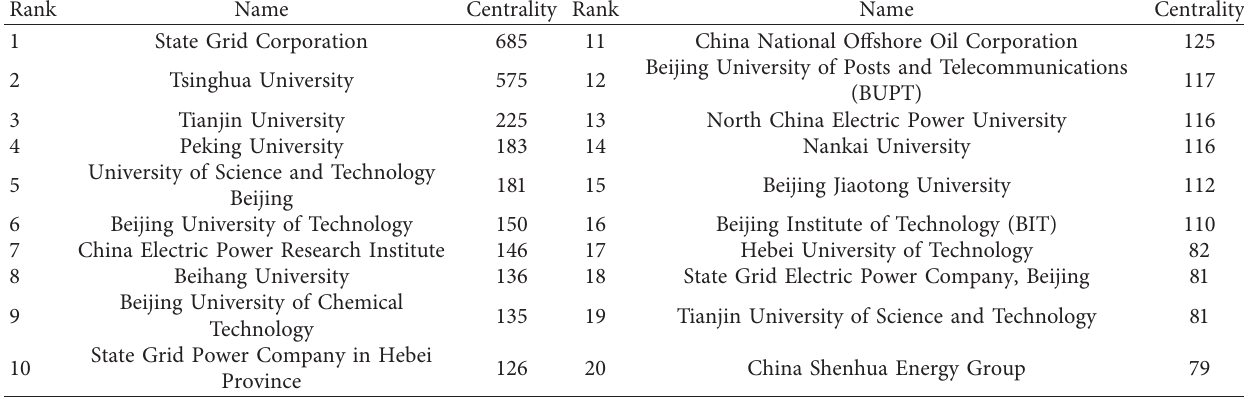
Table 2: The top 20 organizations with the highest degree centrality in BTH Urban Agglomeration.